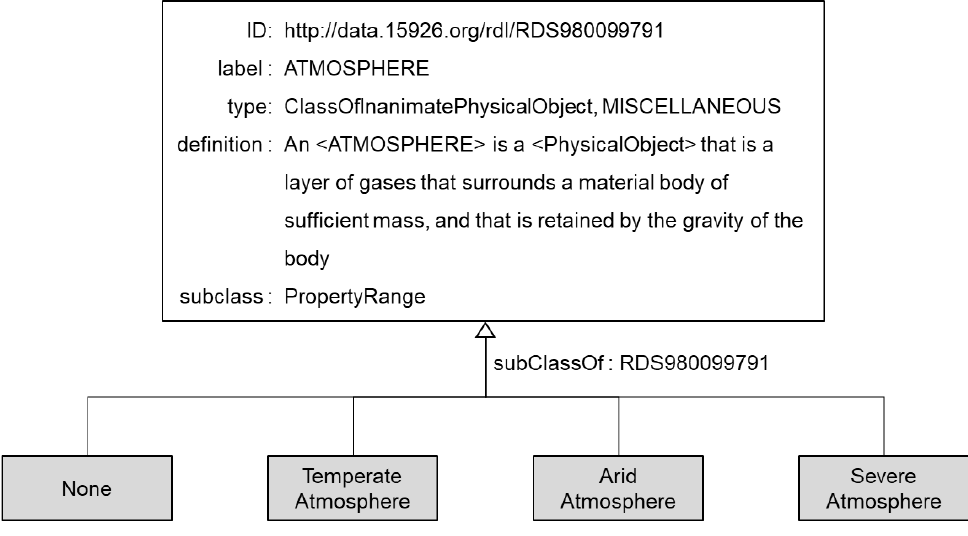
Figure 9. Extension of ISO 15926 reference data.